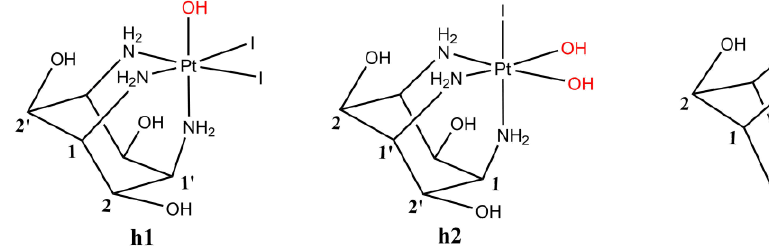
Scheme 4. Hydrolytic species of complex 1